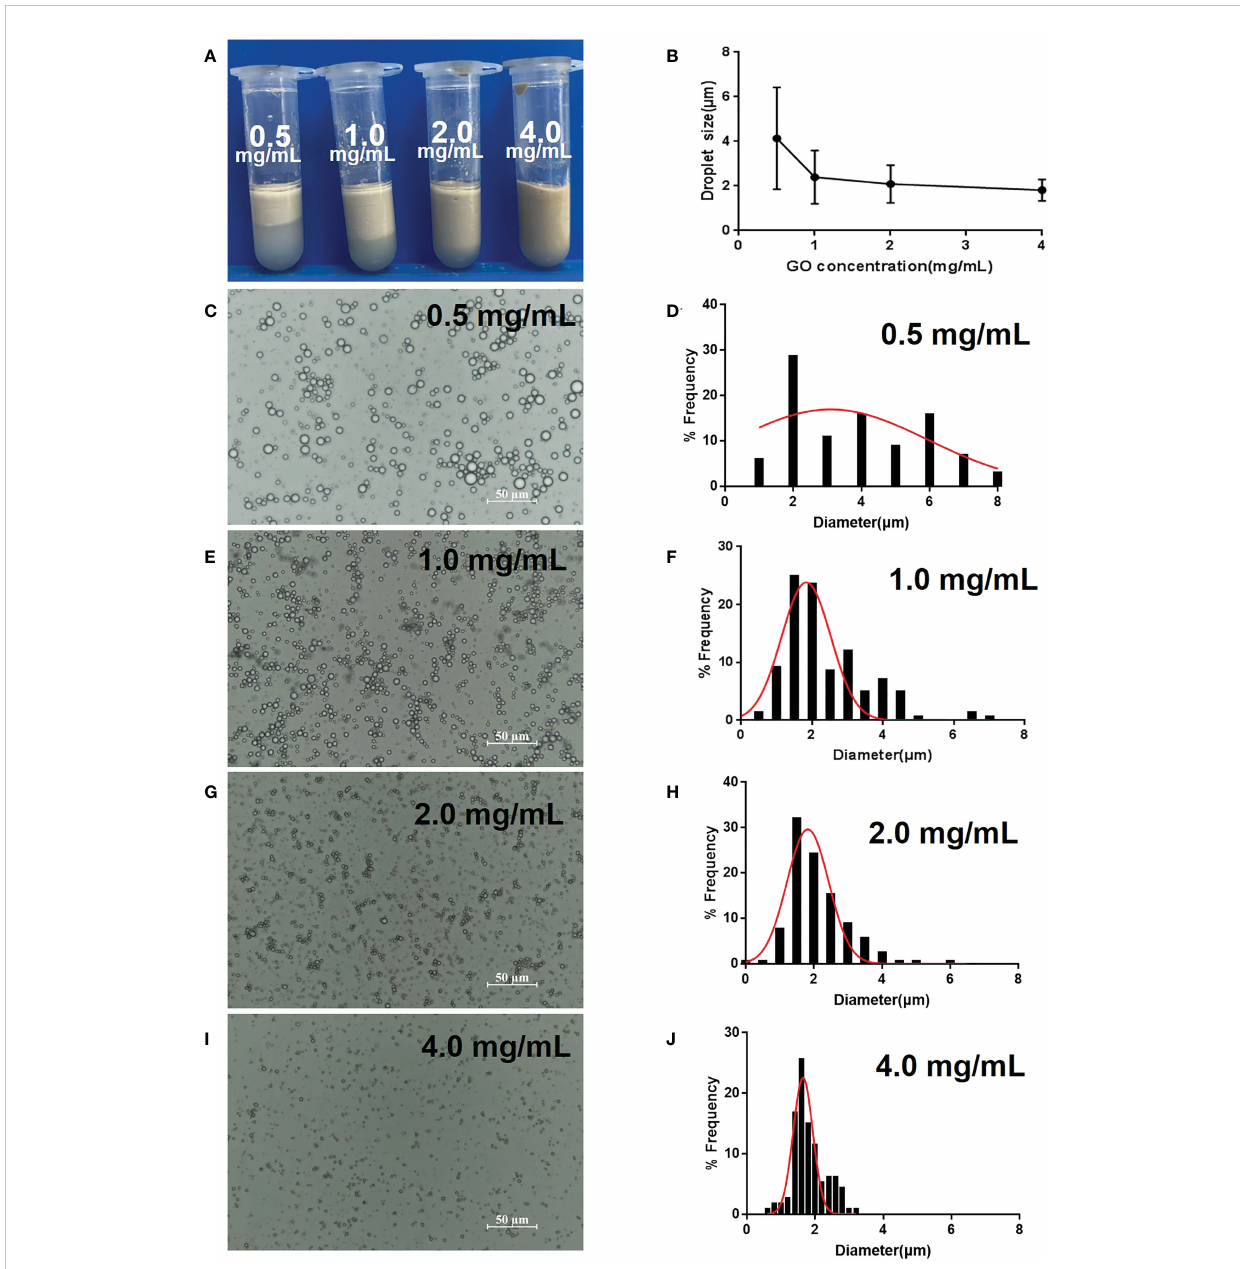
FIGURE 1 Optimization of GPE based on different GO concentrations. (A) Appearance of GPEs prepared using different GO concentrations; (B) the average droplet size as a function of GO concentration; (C, E, G, I) optical micrographs and (D, F, H, J) droplet size distributions of the GPEs prepared using different GO concentrations. Preparation conditions: water/oil ratio 10:2, sonication at 163 W for 2 min, with squalene as the oil phase under natural salinity and pH conditions. GO, graphene oxide; GPE, GO-stabilized Pickering